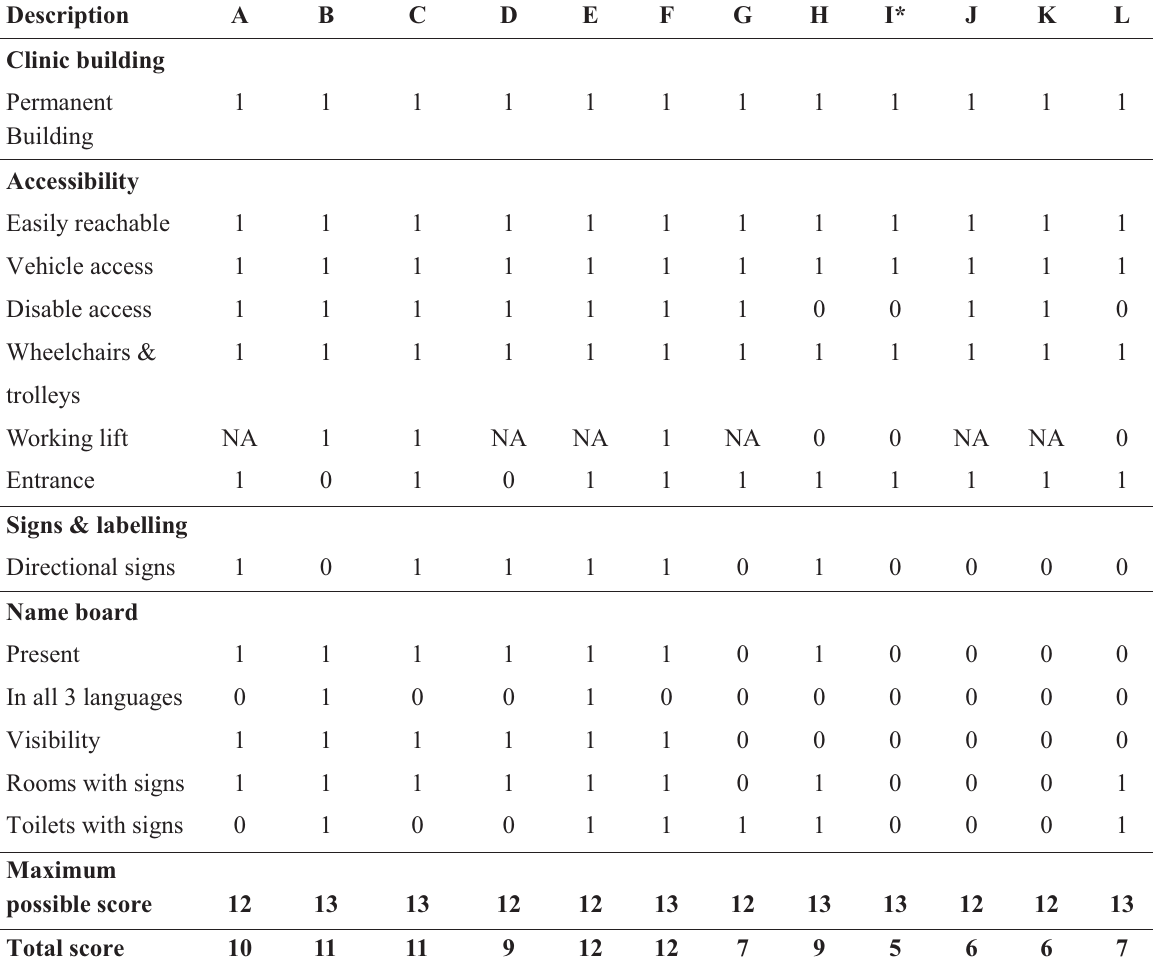
Table 2: Distribution by accessibility and directional signs to leprosy clinics in the Western